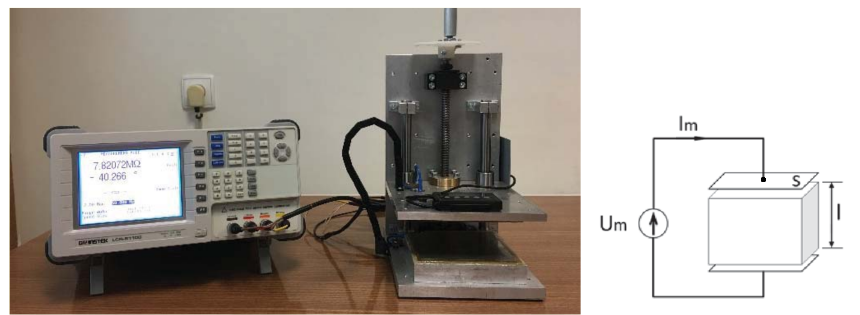
Figure 1: Picture and scheme of device constructed to measure electrical conductivity of solid materials with biological origin